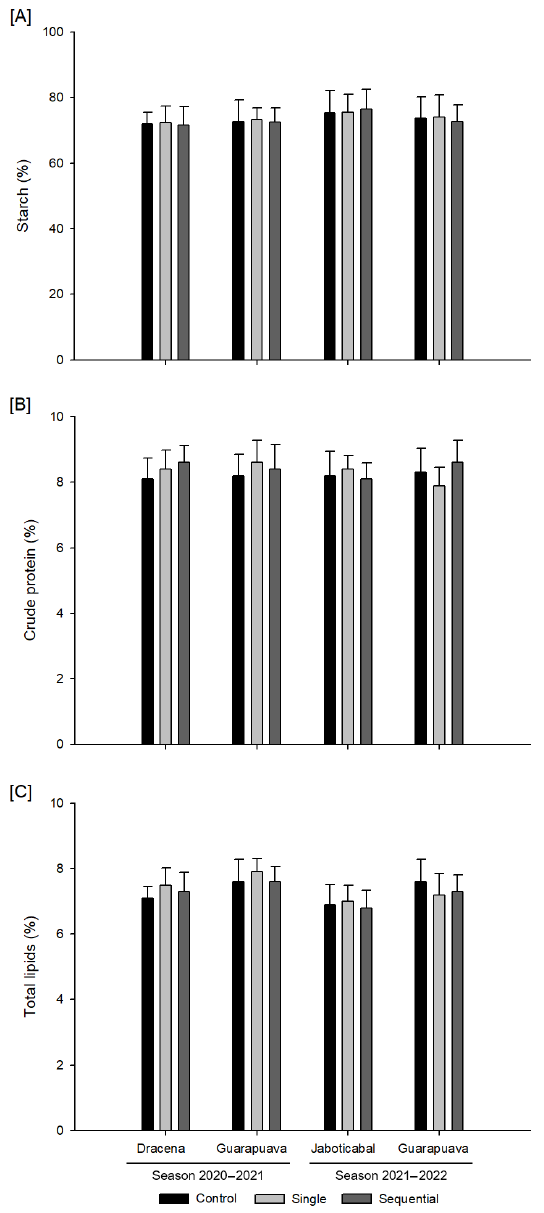
Figure 4. Content of starch ( A ), crude protein ( B ), and total lipids ( C ) of grain from GR maize grown with no glyphosate application (control), with a single application of glyphosate at 980 g of a.e. ha − 1 at stage V5 (single) and a sequential application of glyphosate at 520 + 980 g of a.e. ha − 1 at stage V3 and stage V7, respectively (sequential), in different locations and seasons. Error bars are one SE of the mean from ten